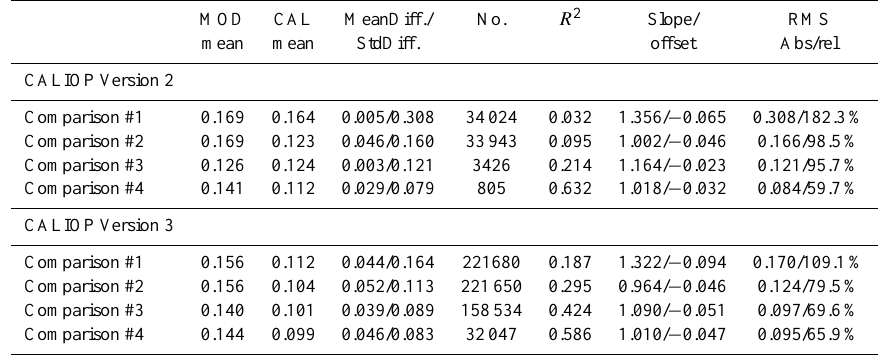
Table 3. MODIS vs. CALIOP AOD532, April 2007, over-ocean.